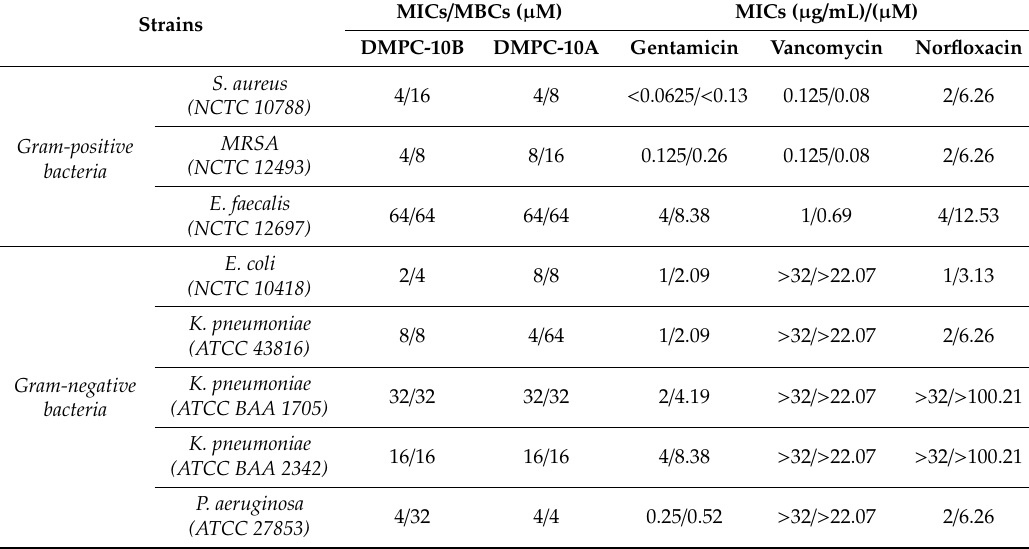
Table 1. The minimal inhibitory concentrations (MICs) and minimal bactericidal concentrations (MBCs) of DMPC-10A and DMPC-10B against selected microorganisms. MICs of antibiotics (gentamicin, vancomycin and norfloxacin) were tested as well.